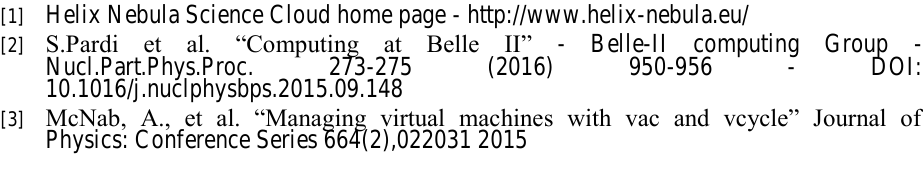
Figure 4.1 – The picture shows the number of running jobs on the OTC infrastructure